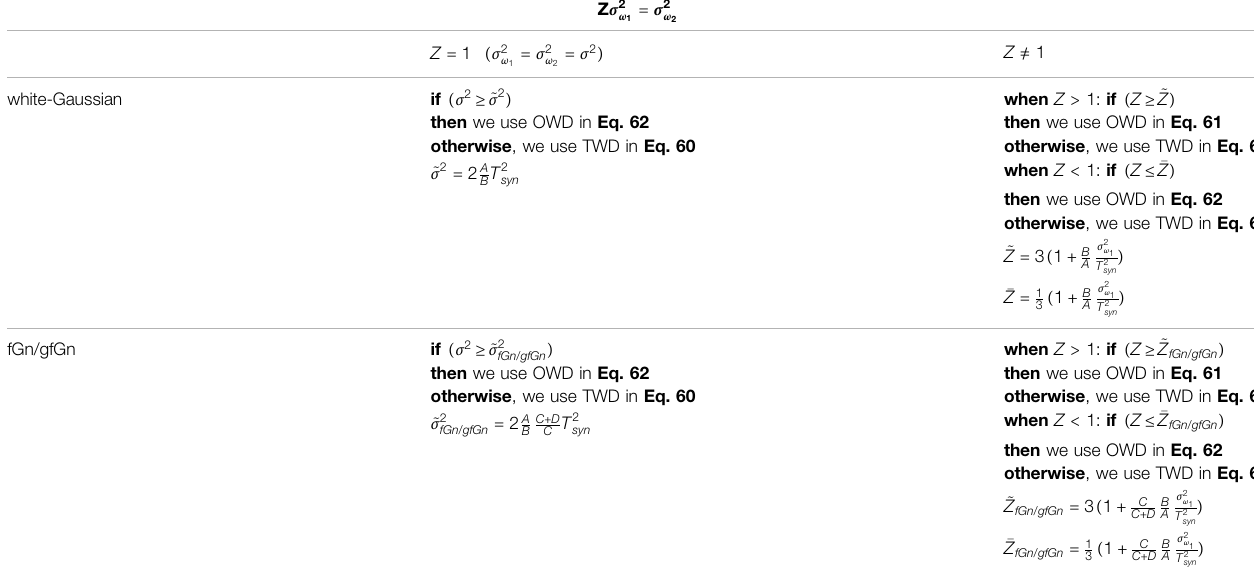
TABLE 1 | Summary of the conditions where the suggested estimator have the possible lower